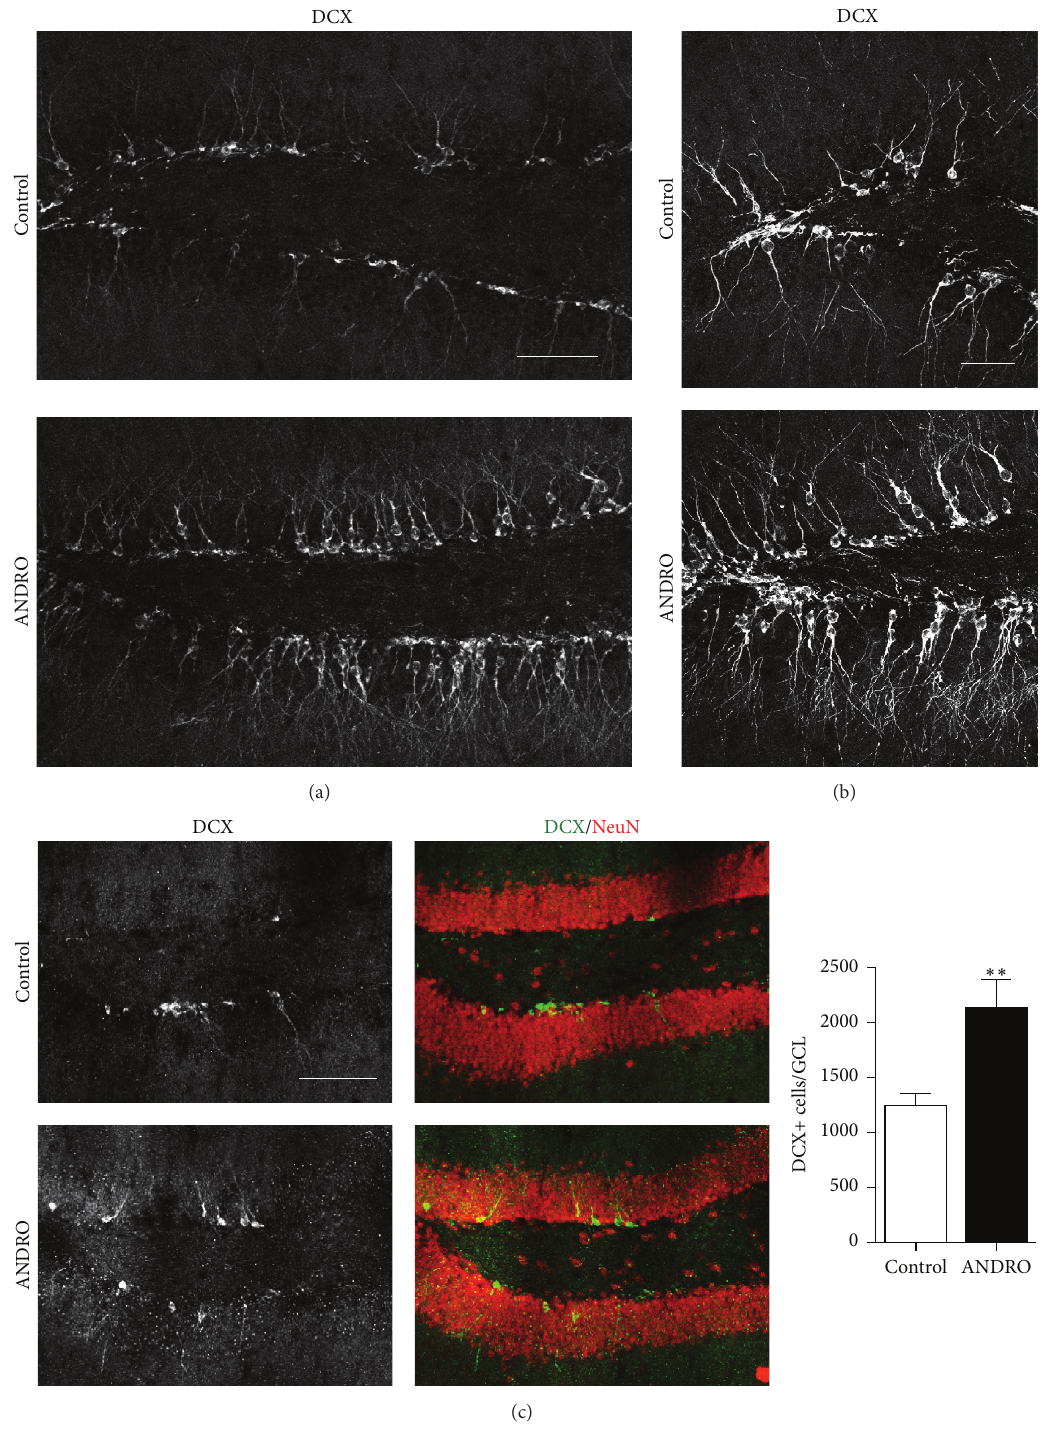
Figure 3: ANDRO increases the density of immature neurons in the dentate gyrus of adult mice. (a) Representative immunostaining of DCX in 2-month-old mice treated with vehicle or ANDRO for 4 weeks. Scale bar: 50 𝜇 m. (b) Higher magnification of representative DCX immunostaining in control and ANDRO-treated mice. Scale bar: 30 𝜇 m. (c) Representative images of double immunostaining for DCX and NeuN in 10-month-old mice treated with vehicle or ANDRO for 4 weeks. Scale bar: 100 𝜇 m. Graph quantification of total number of DCX- positive (DCX+) cells in the GCL 10-month-old mice. Bars represent mean ± S.E. ( 𝑛 = 5 mice). ∗∗ 𝑃 < 0.01 , Student’s 𝑡